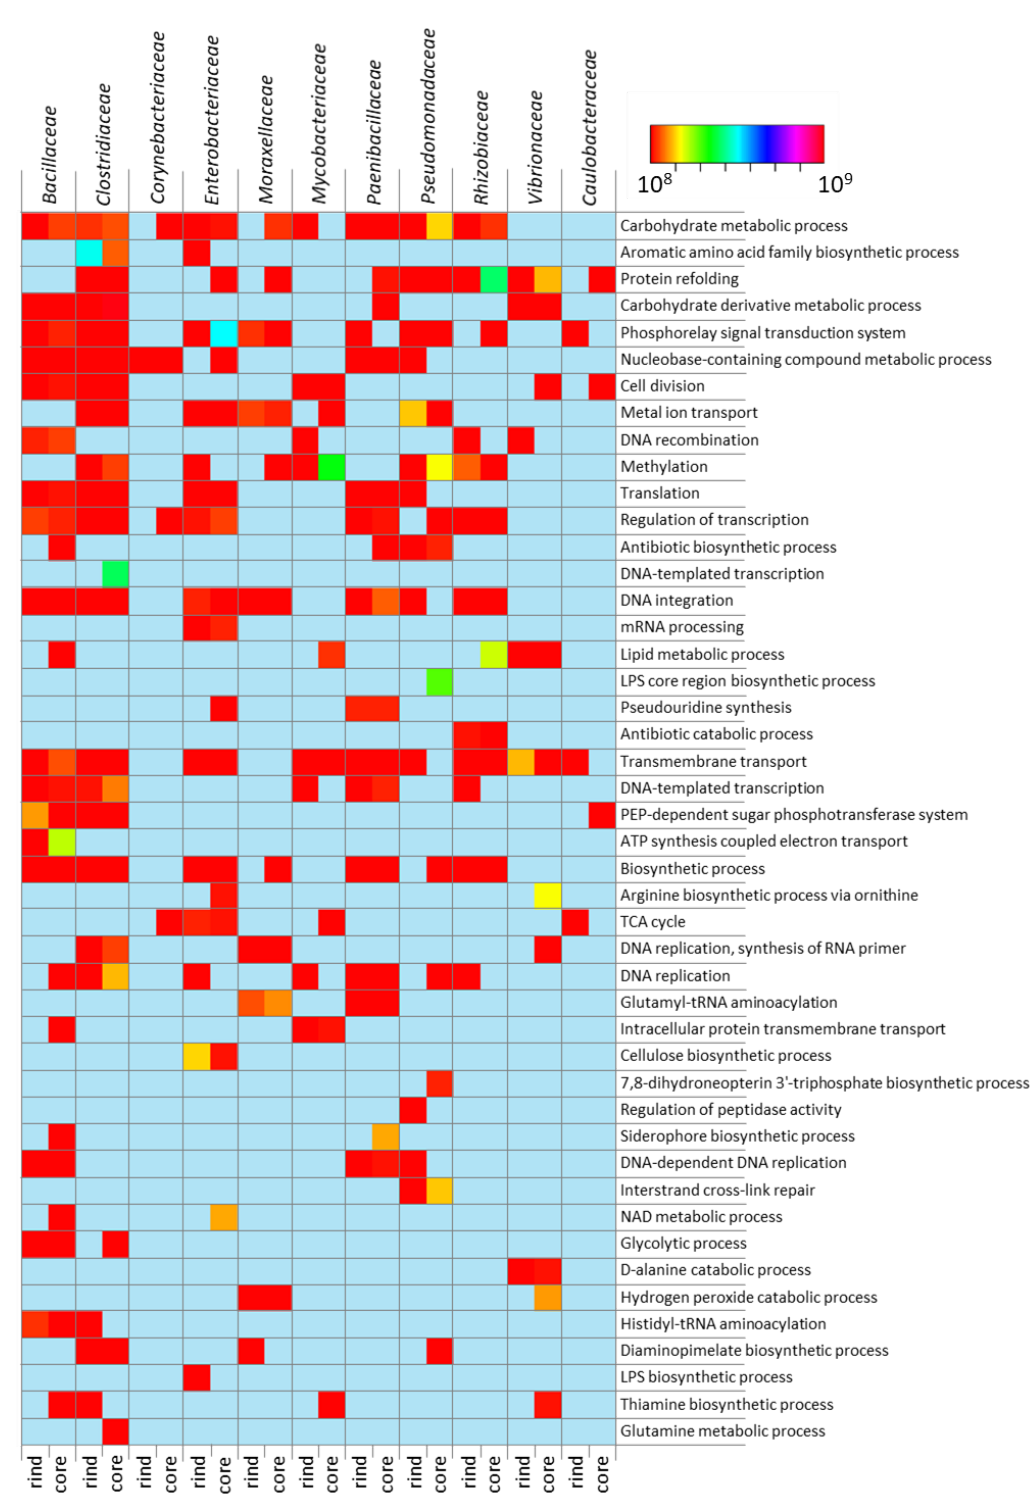
Figure 5. Functional characterization of the rind and core microbiota. The heatmap displays the biological processes participated in by the microbiota of the core and rind. The figure details the functional concerns of the bacterial families whose cumulative protein abundance was above the pre-fixed threshold of 1% total protein abundance. The color scale is relative to the protein abundance